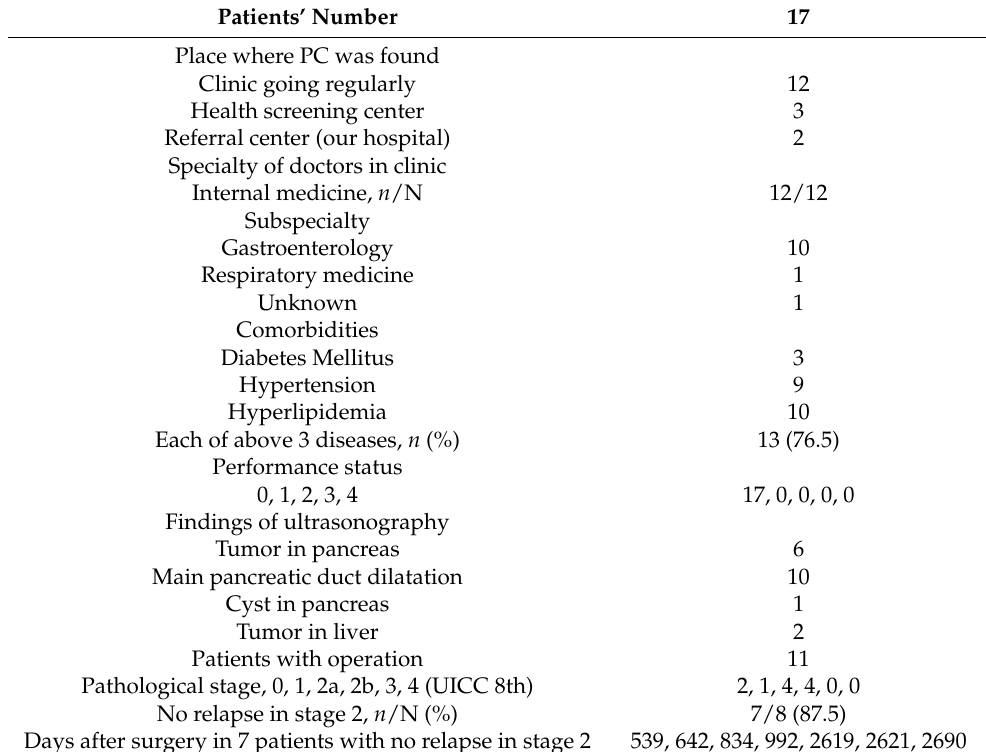
Table 5. Summary of patients in group